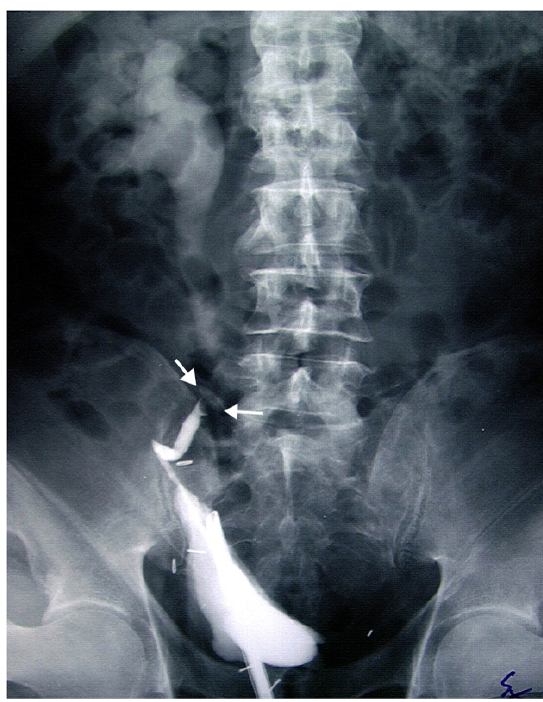
FIGURE 1. Ascending ureteropielography highlighting a ureteral filling defect (note the delayed clearance of contrast medium of the previous